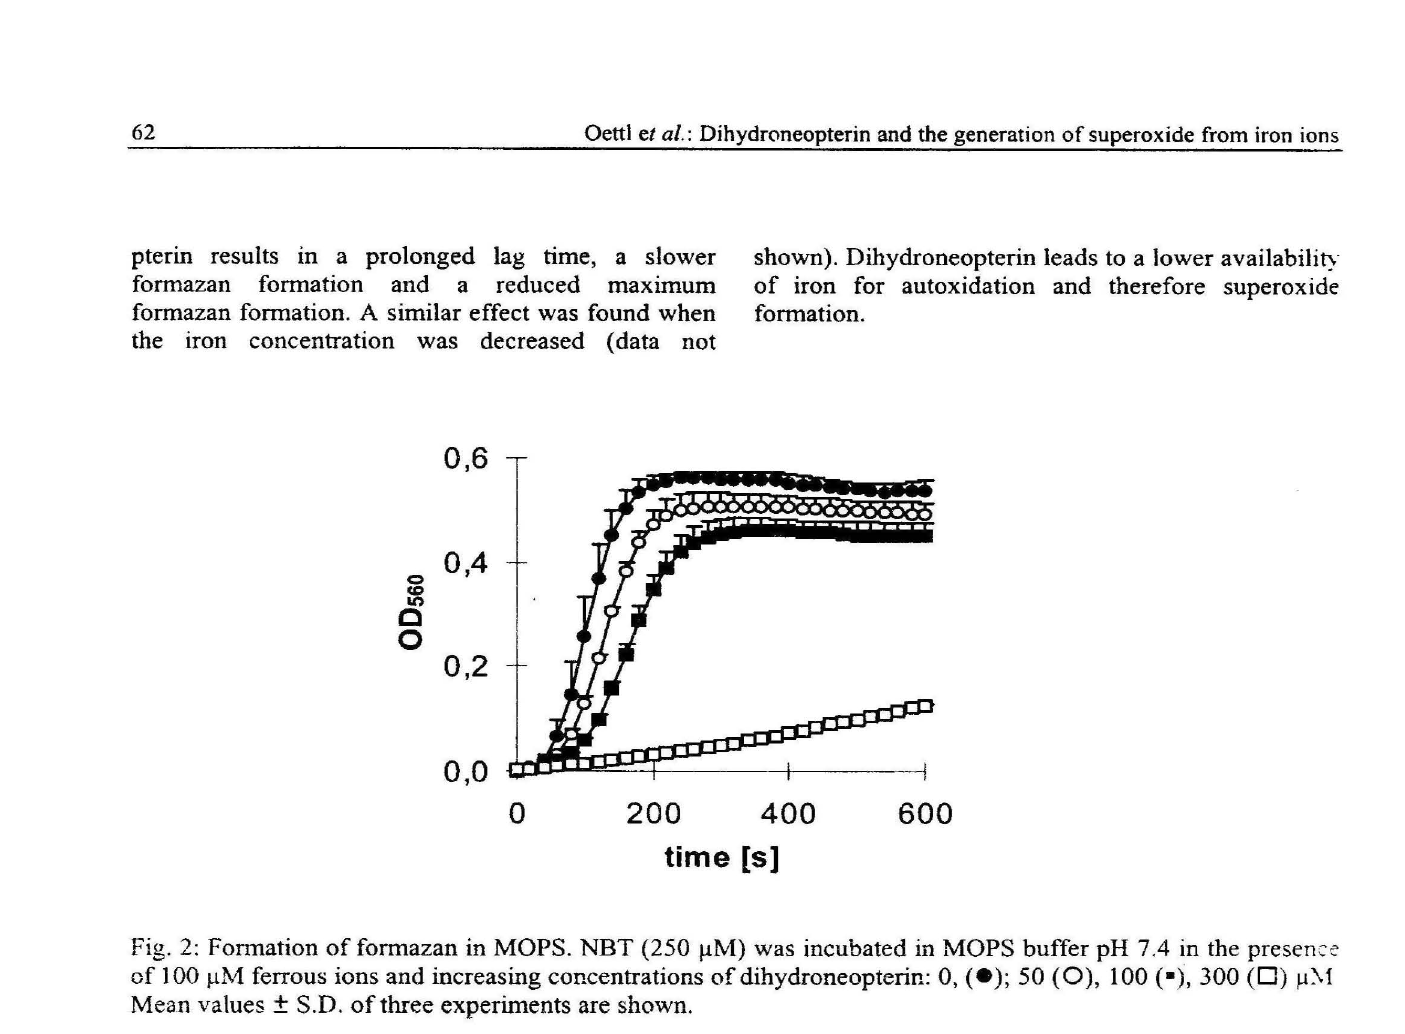
Fig. 2: Formation of formazan in MOPS. NBT (250 11M) was incubated in MOPS buffer pH 7.4 in the presence of 100 11M ferrous ions and increasing concentrations of dihydroneopterin: 0, (e); 50 (0), 100 (-),300 (0) 11:-"1 Mean values ± S.D. of three experiments are